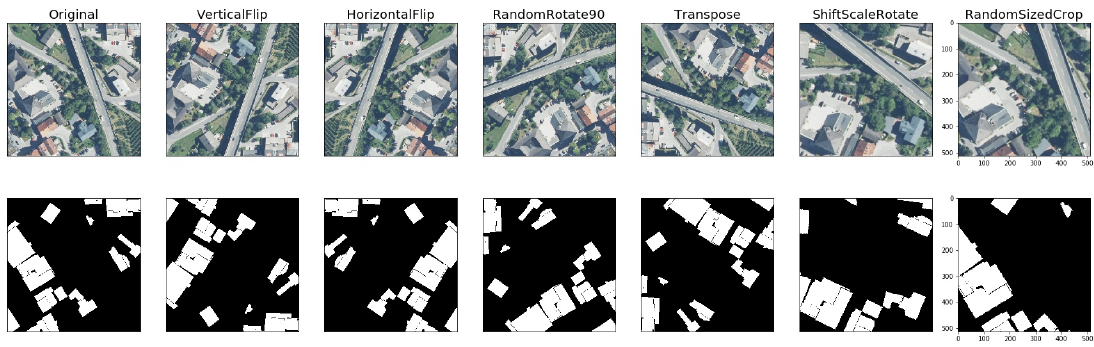
Figure 3. An example of geometry-preserving transforms applied to satellite images ( top row ) and ground truth binary masks ( bottom row ) from the Inria Aerial Image Labeling dataset